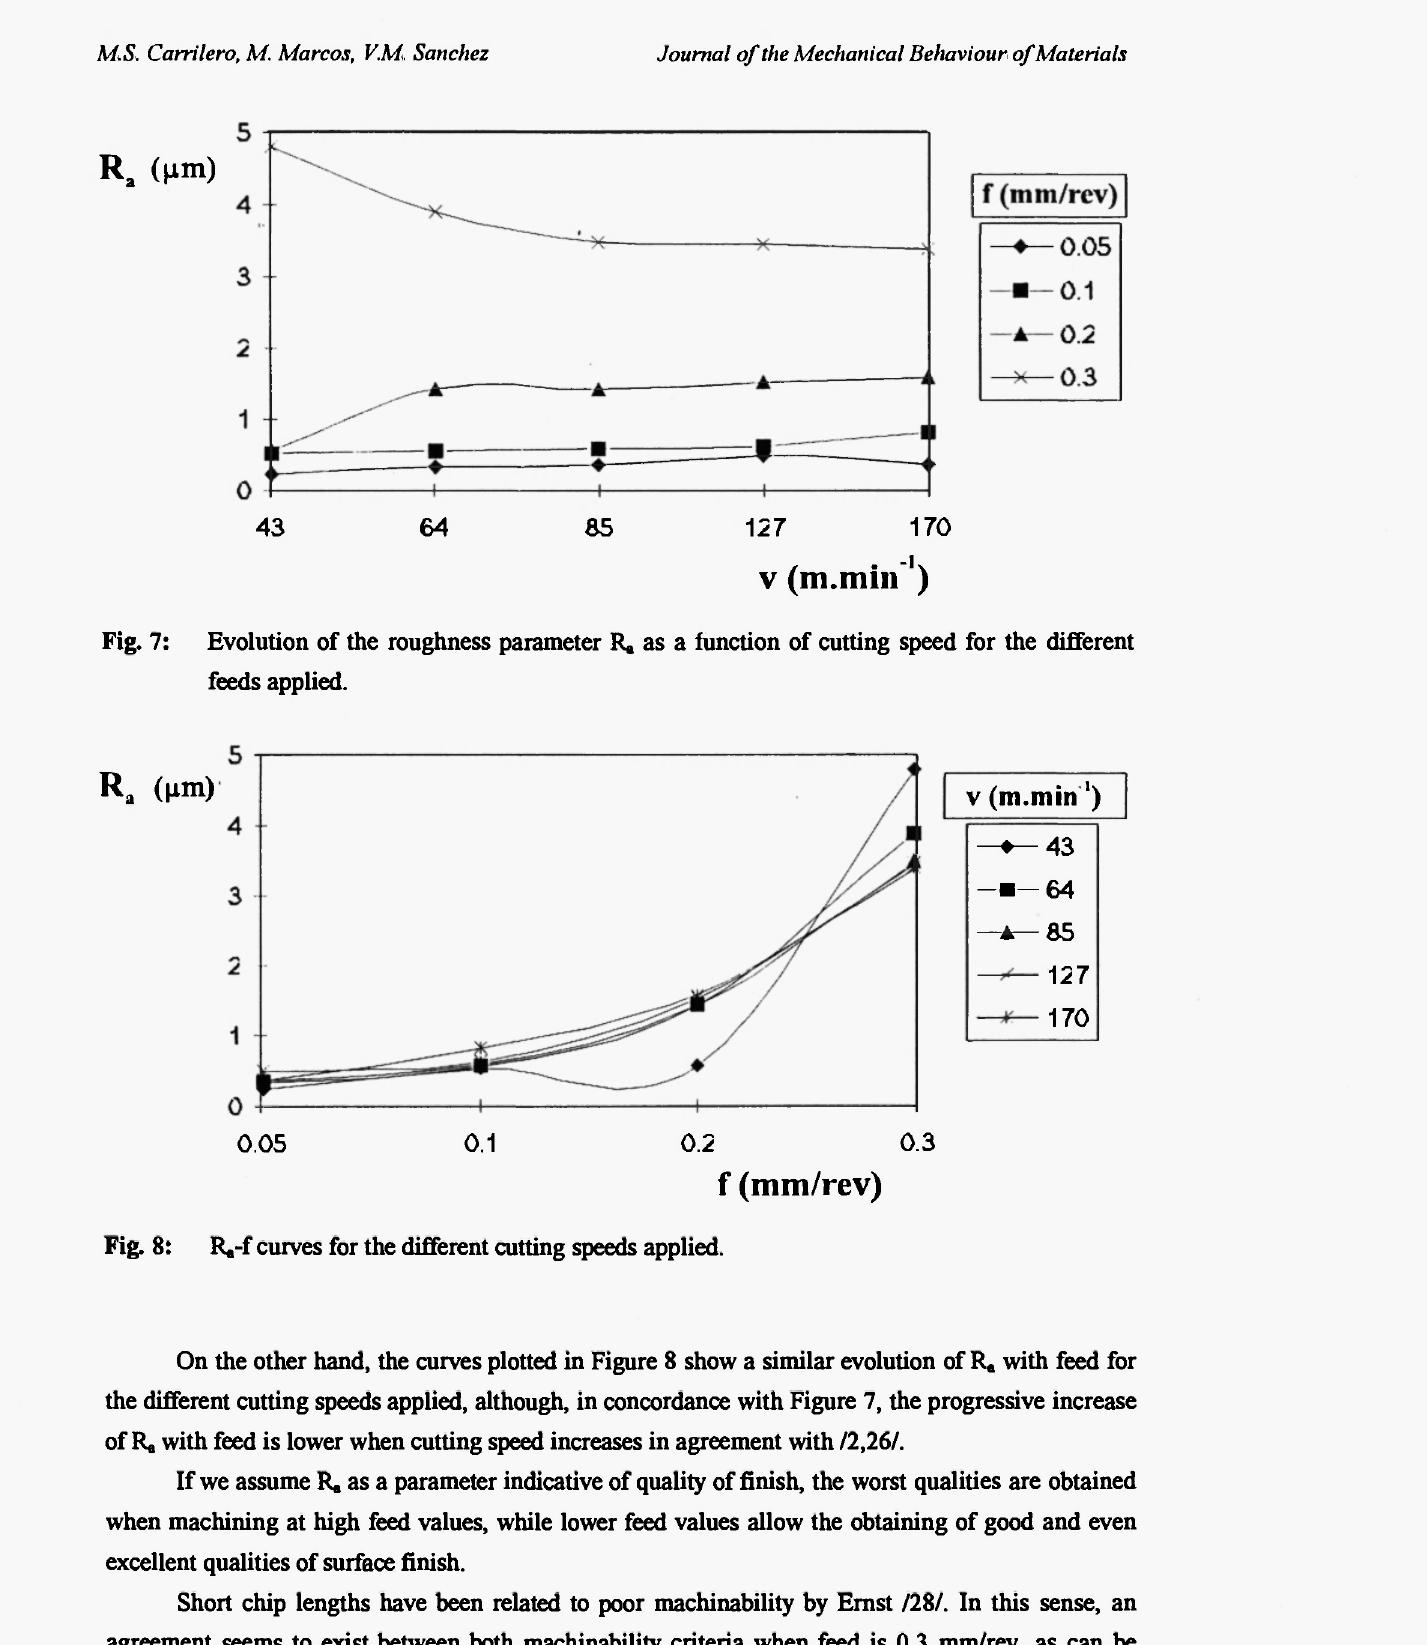
Fig. 8: R,-f curves for the different cutting speeds